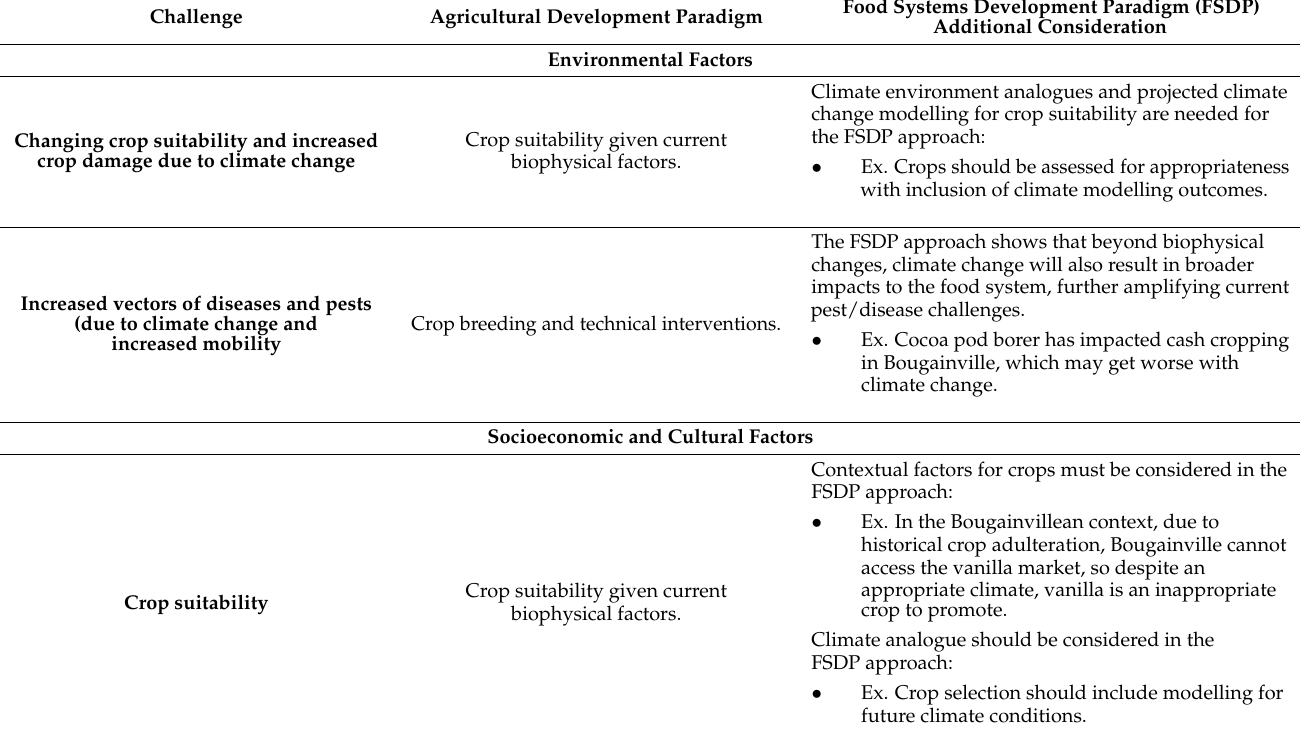
Table 3. Challenges to the food system, how the classical agricultural development paradigms would address those challenges, and the illustration of how the food systems development paradigm ad- dresses the challenge in a more thorough manner, more suited for the design of development projects. Challenge Agricultural Development